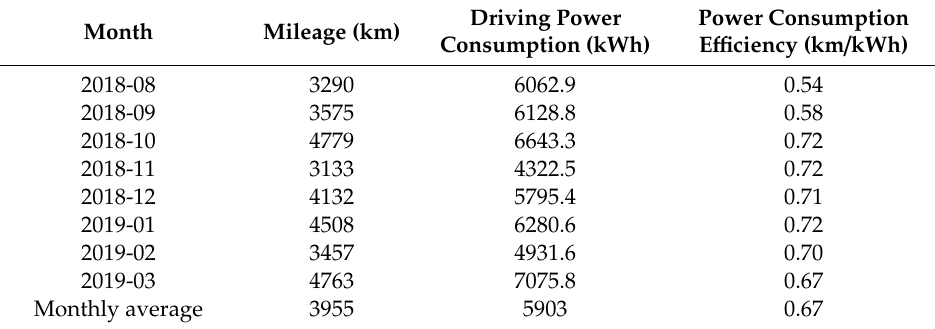
Table 8. Statistics on the monthly mileage and power consumption in operating